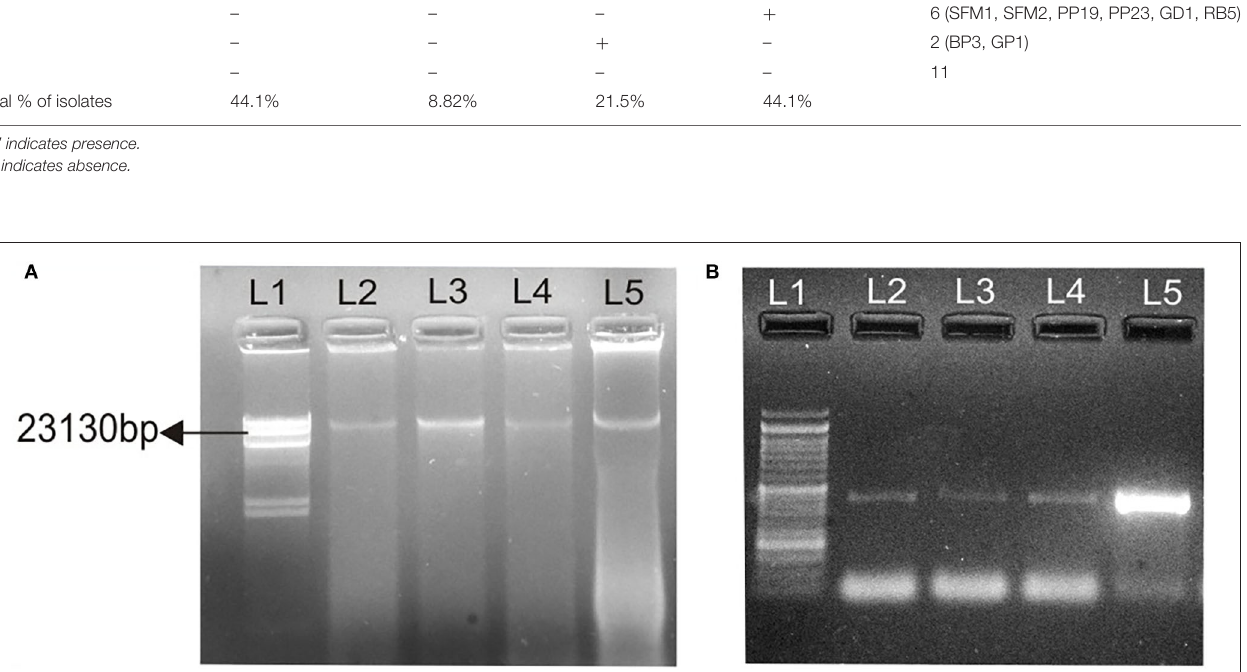
FIGURE 3 | Transfer of virulence gene from isolated Aeromonas strain GP3 to E. coli DH5 α . (A) lane 1, Lambda DNA/ Hind III digest: molecular weight marker; lane 2, 23-kb plasmid (23,130 bp) of GP3 (donor); L3, L4, L5, 23kb plasmids detected in transconjugants, (B) 431-bp PCR amplicons of the aerolysin/haemolysin ( aer/haem ) encoding gene from donor and transconjugants; lane 1, molecular weight marker as 50-bp DNA ladder; lanes 2-4, transconjugants and lane 5, donor